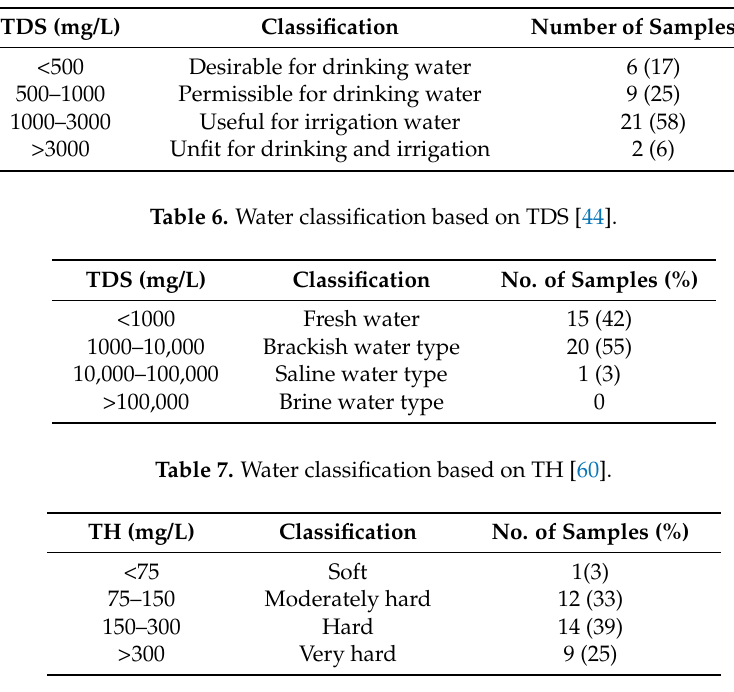
Table 5. Davis and De Wiest [59] Classification based on TDS.